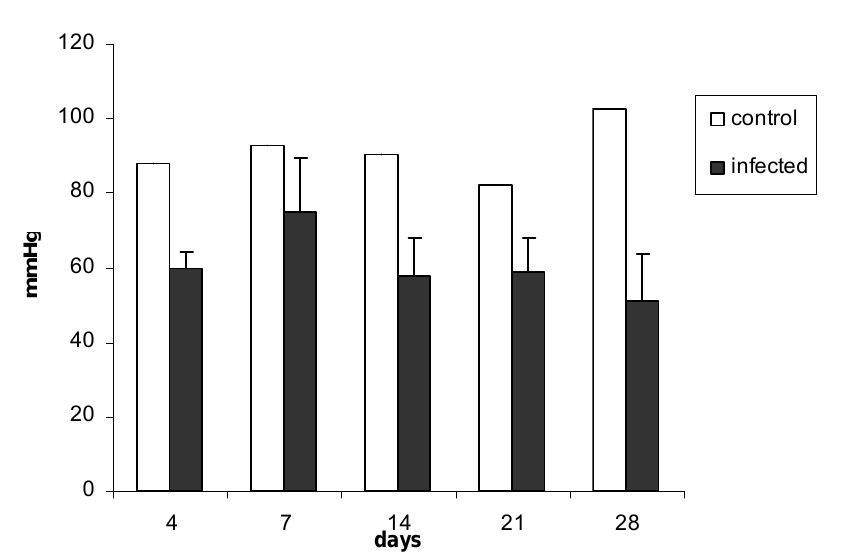
±SD) in blood samples of hamsters 2